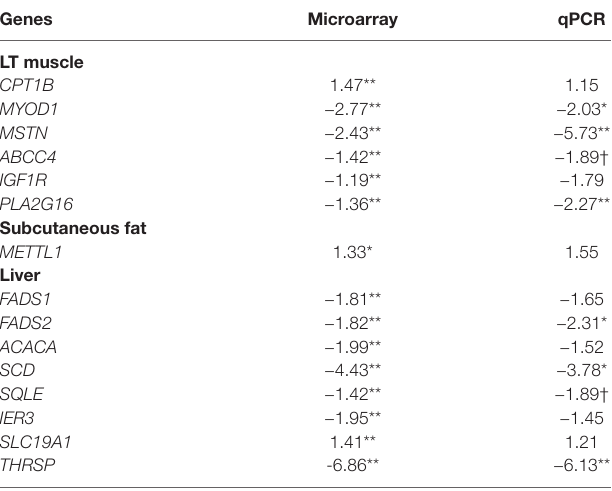
TABLE 6 | Real-time PCR confirmation of the microarray results. Gene expression changes in LT muscle, liver and subcutaneous fat in ALF vs CON comparison, and the fold change (FC) obtained with microarray and qPCR